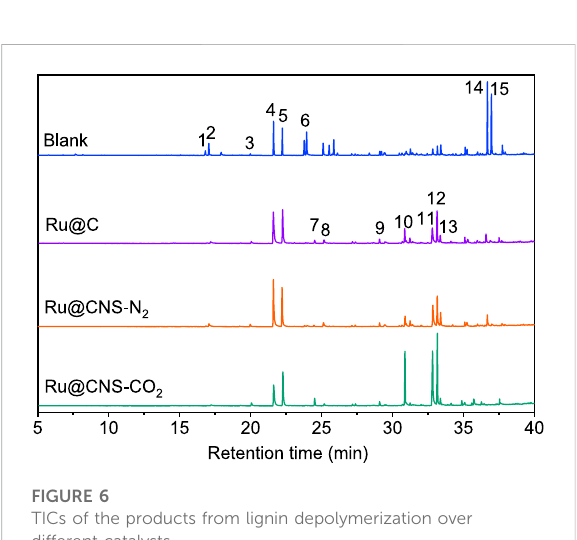
FIGURE 5 NH 3 -TPD patterns of the three catalysts.